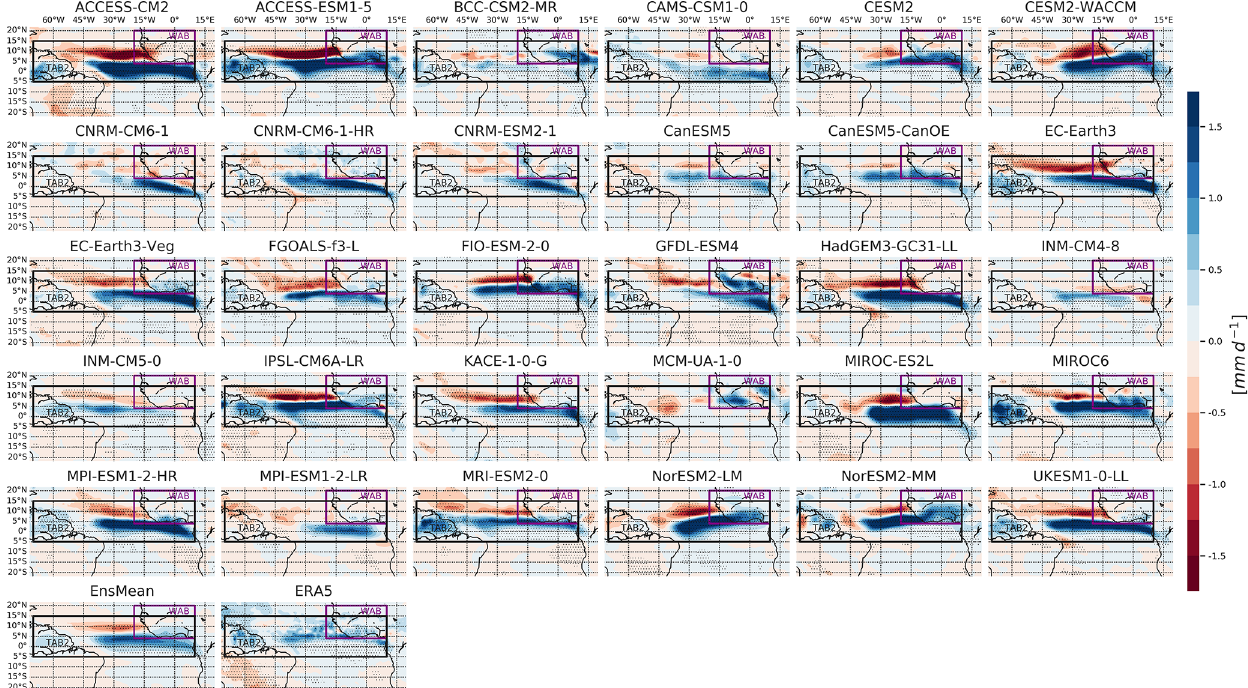
Figure 4. Regression maps of the JAS rainfall anomalies onto the standardized JAS ATL3 SST index over 1985–2014. Stippling in the EnsMean indicates grid points where more than 50% of the models show significant coefficients at 95% level and more than 80% of the models agree on the sign of the regression coefficient. Stippling in each model and ERA5 indicates significant regression coefficients at 95%